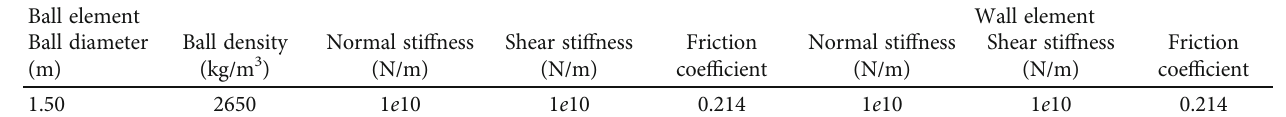
Table 1: Mesoparameters used in the numerical simulation of Shum Wan Road landslide.